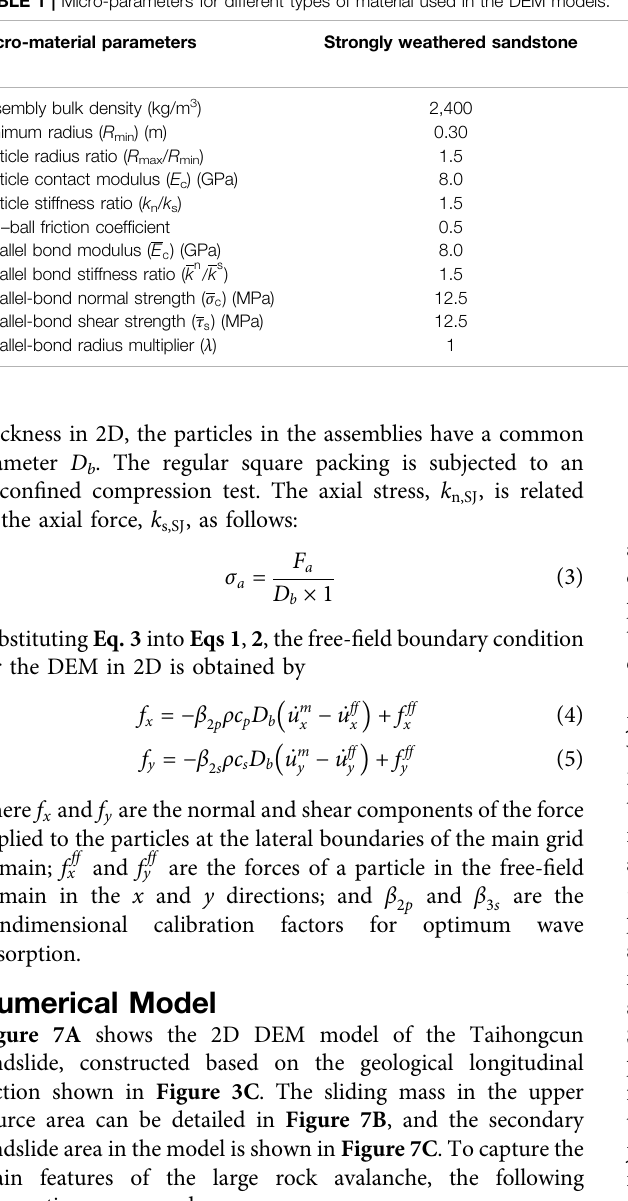
TABLE 1 | Micro-parameters for different types of material used in the DEM